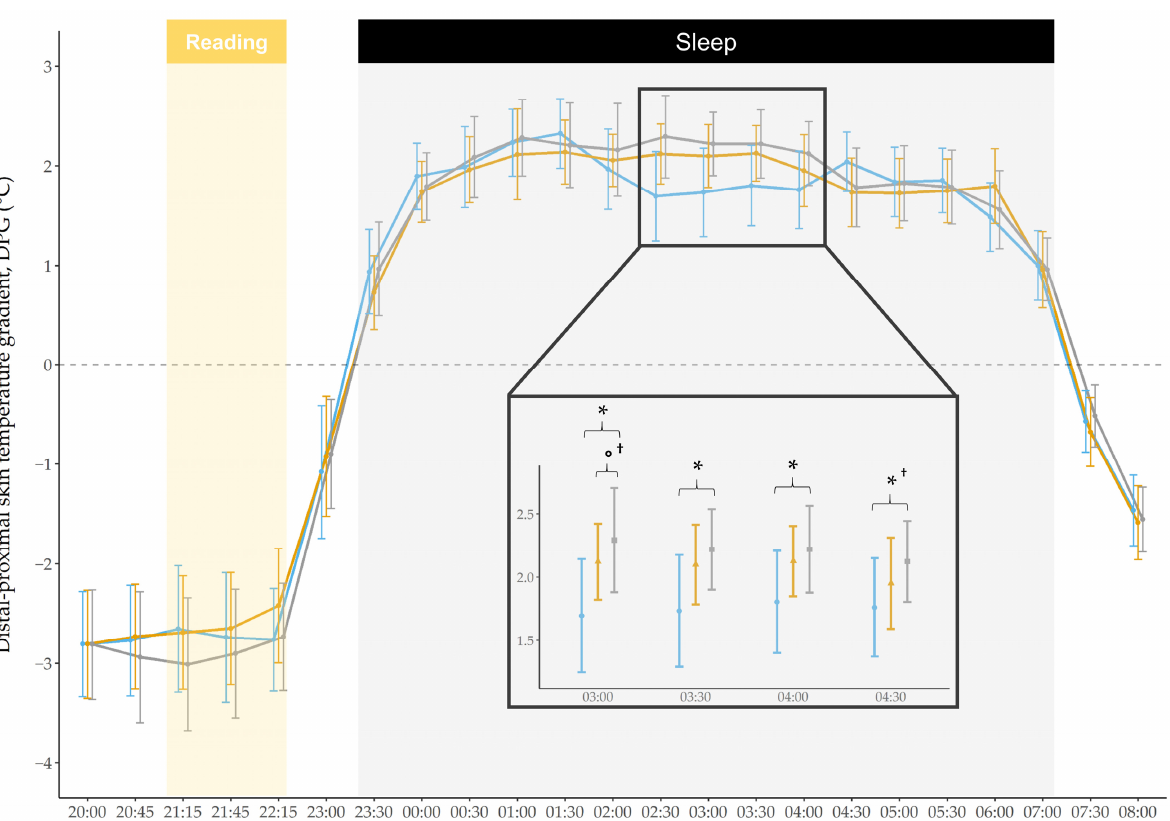
Figure 4. Trajectory of the distal-proximal gradient (mean and 95% confidence intervals). DPG was significantly lower in the “no filter” condition compared to the “book” condition from 3:00 to 4:30 and by trend lower in the “filter” condition compared to the “book” condition at 3:00. Yellow background = light exposure (reading session); gray background = lights turned off (sleep). *: p ≤ 0.05; ◦ : p < 0.10; †: p adj . >